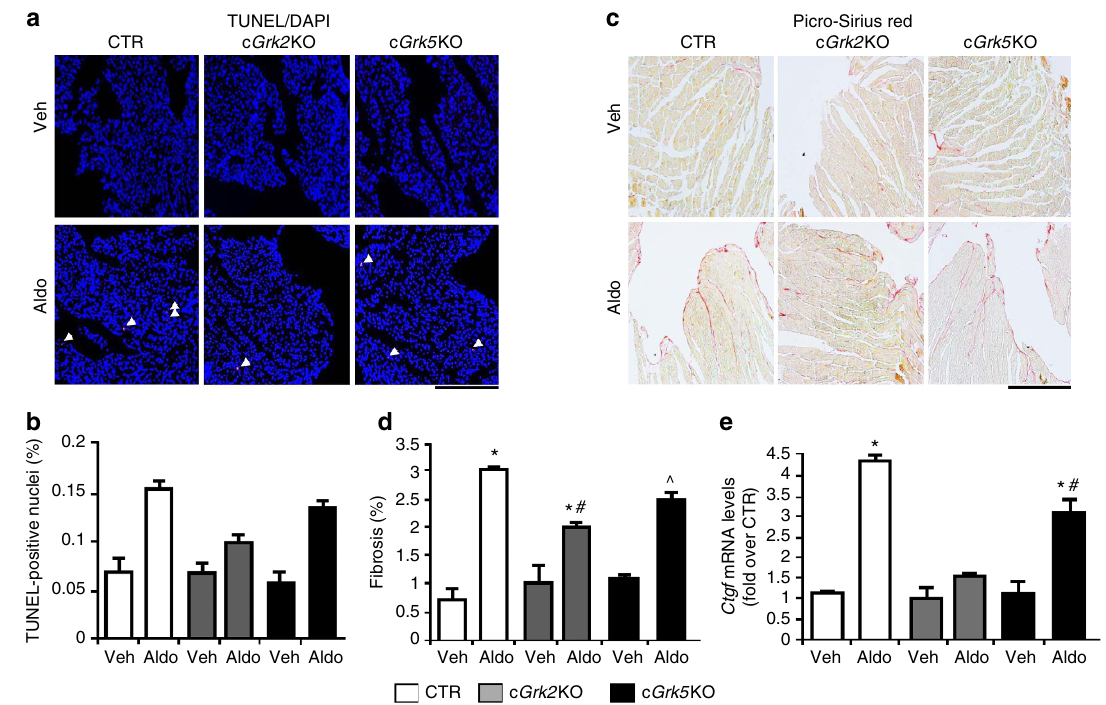
Figure 8 | Cardiac-specific Grk2 KO and Grk5 KO mice are protected against the negative molecular effects induced by aldosterone (Aldo). ( a , b ) Representative images (upper scale bar, 200 m m) and quantitative data ( n ¼ 8 mice each group; bottom) showing findings of myocyte cell death via TUNEL staining after 4 weeks of Aldo treatment of CTR, c Grk2 KO and c Grk5 KO mice; * P o 0.05 versus CTR Veh; # P o 0.05 versus CTR Aldo; ^ P o 0.05 versus all. ( c , d ) Representative images (upper scale bar, 200 m m) and quantitative data ( n ¼ 8 mice each group; bottom) showing percentage of cardiac fibrosis via Picro-Sirius red staining following 4 weeks of Aldo treatment of CTR, c Grk2 KO and c Grk5 KO mice; * P o 0.05 versus CTR Veh; # P o 0.05 versus CTR Aldo; ^ P o 0.05 versus all. ( e ) Bar graph showing quantitative data of qPCR experiments to evaluate myocardial Ctgf mRNA levels from CTR, c Grk2 KO and c Grk5 KO hearts ( n ¼ 8 each group) after Veh or Aldo treatment; * P o 0.05 versus CTR Veh; # P o 0.05 versus CTR Aldo. ( b , d , e ) Statistical significance between groups was determined by one-way ANOVA with Bonferroni post hoc correction. All data are shown as mean ±